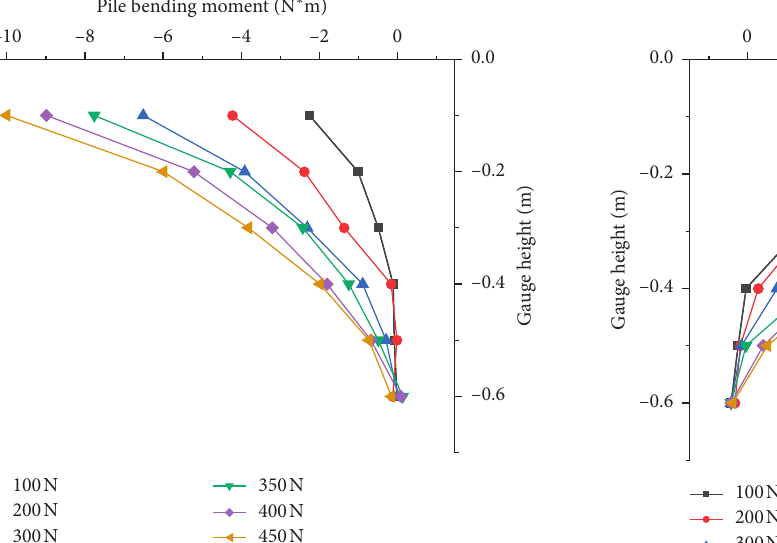
Figure 16: Curve of bending moment of straight pile loaded in the reverse direction of y .